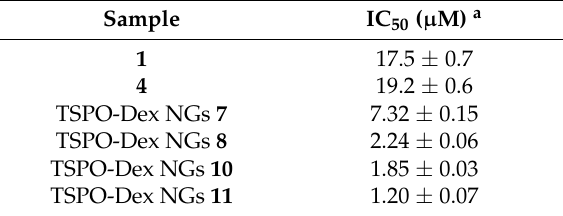
Table 6. Cytotoxicity against C6 Glioma cells of TSPO-Dex